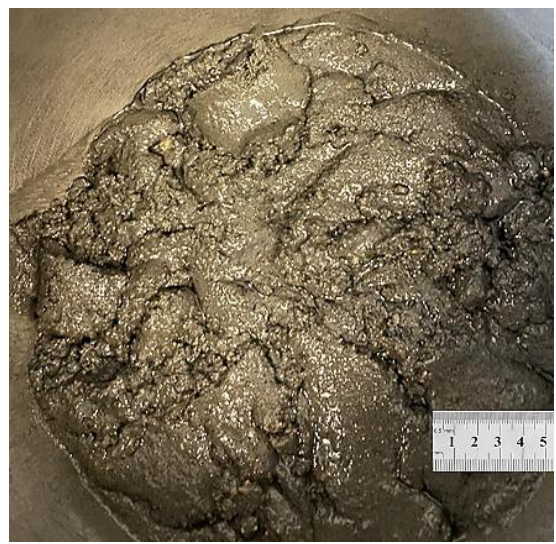
Figure 7. Geopolymer mortar after mixing.